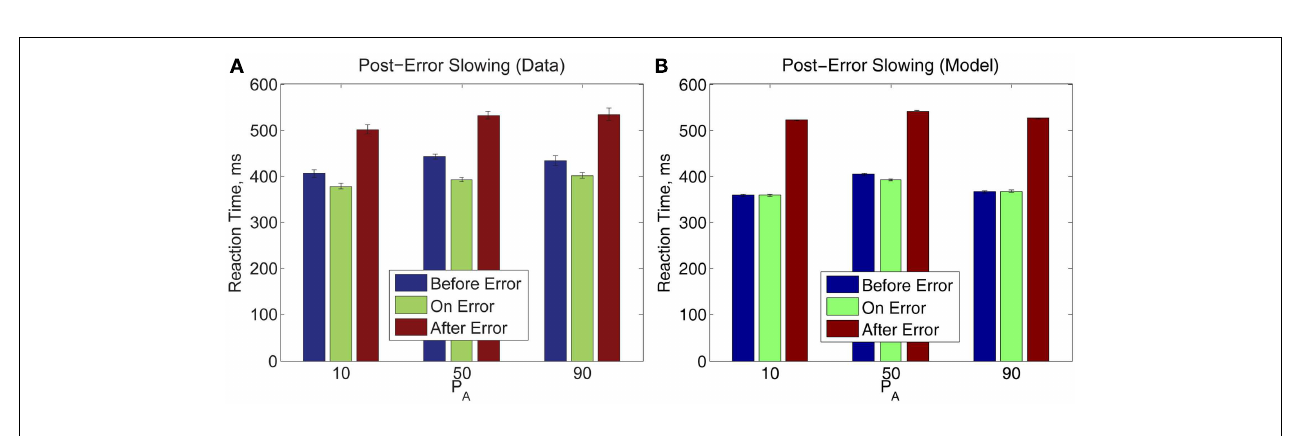
plot (A) represent the standard error of the mean, and in (B) the average value of standard error of the mean over 10 simulation runs (see Section 2.4 for